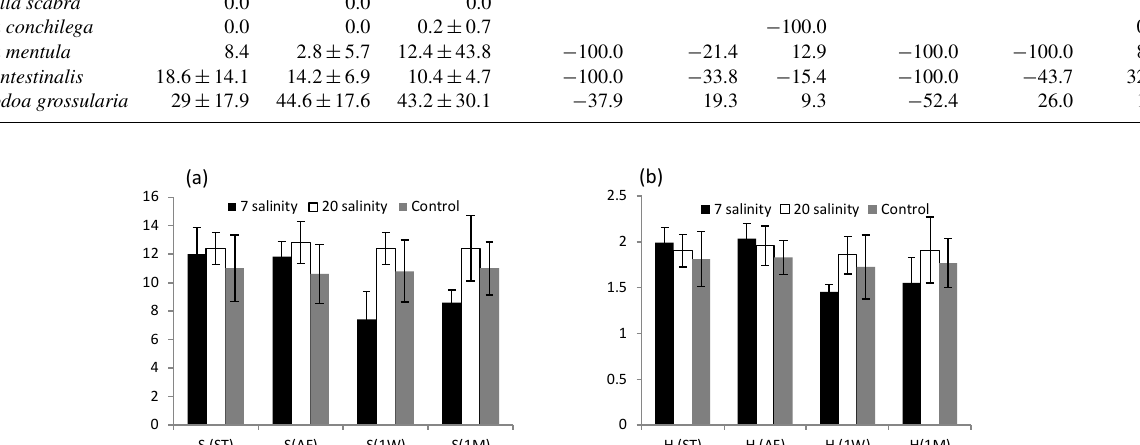
Figure 2. (a) Average number of species ( S ) and (b) Shannon–Wiener diversity index ( H (cid:48) ) of 2-year-old biofouling communities developed on PVC panels at 1.5m depth in a marina off Plymouth, UK. Panels exposed to salinities of 7, 20 and 33 (control) before treatment (ST), immediately after exposure (AF), 1 week after (1W) and after 1 month of exposure (1M). Error bars are ± SD, n = 15.